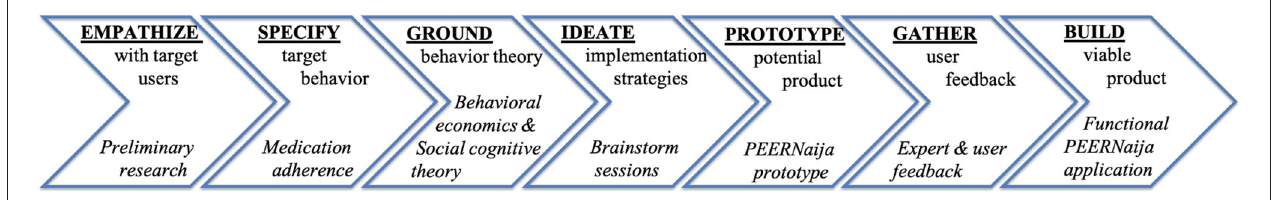
FIGURE 1 | Seven steps of the IDEAS framework employed in the development of PEERNaija .